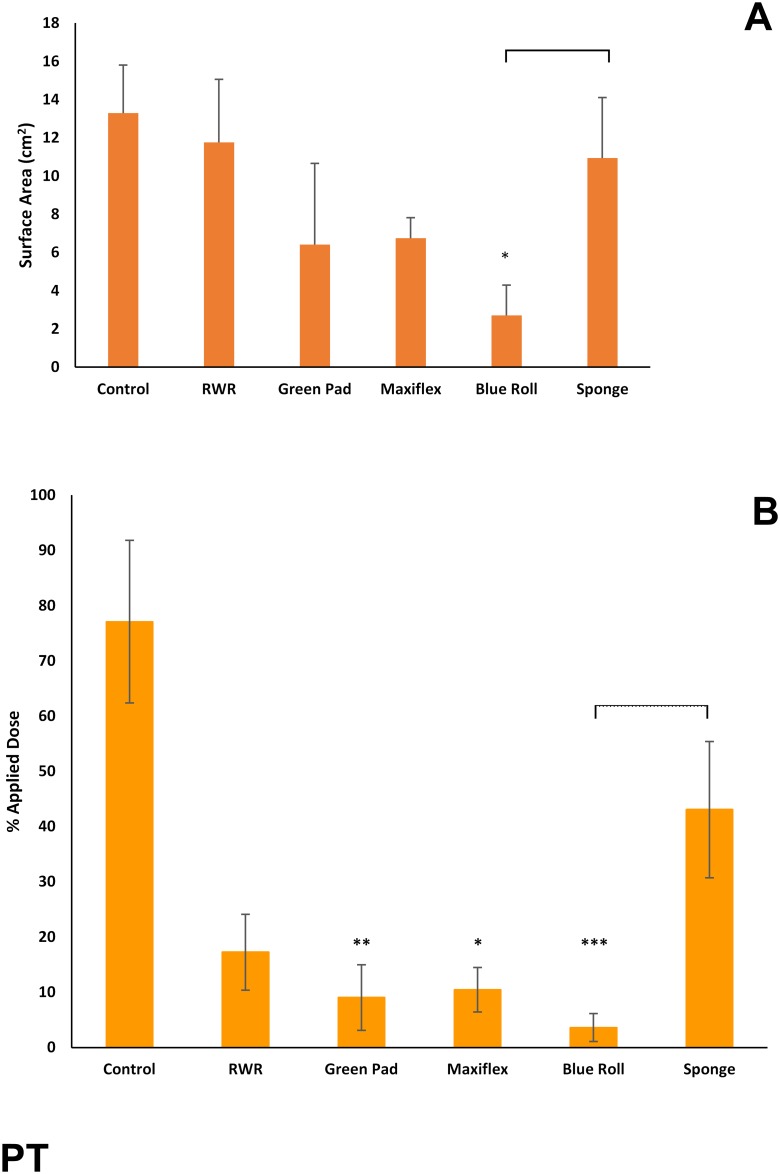
(A) Skin surface spreading and (B) recovery of 14C-parathion (expressed as percentage of applied dose) remaining on, within or penetrated through dermatomed pig skin following decontamination (after 15 minutes) with test products (green incontinence pads, Maxiflex wound dressing, absorbent tissue paper (blue roll) or polyurethane sponge) or the rinse-wipe-rinse method (RWR).All values are mean ± standard deviation of n = 6 replicates. Asterisks indicate significant differences between treated and untreated (control) skin: *p<0.05; **p<0.01; ***p<0.001. Horizontal brackets indicate significant difference (p<0.05) between treatment groups.